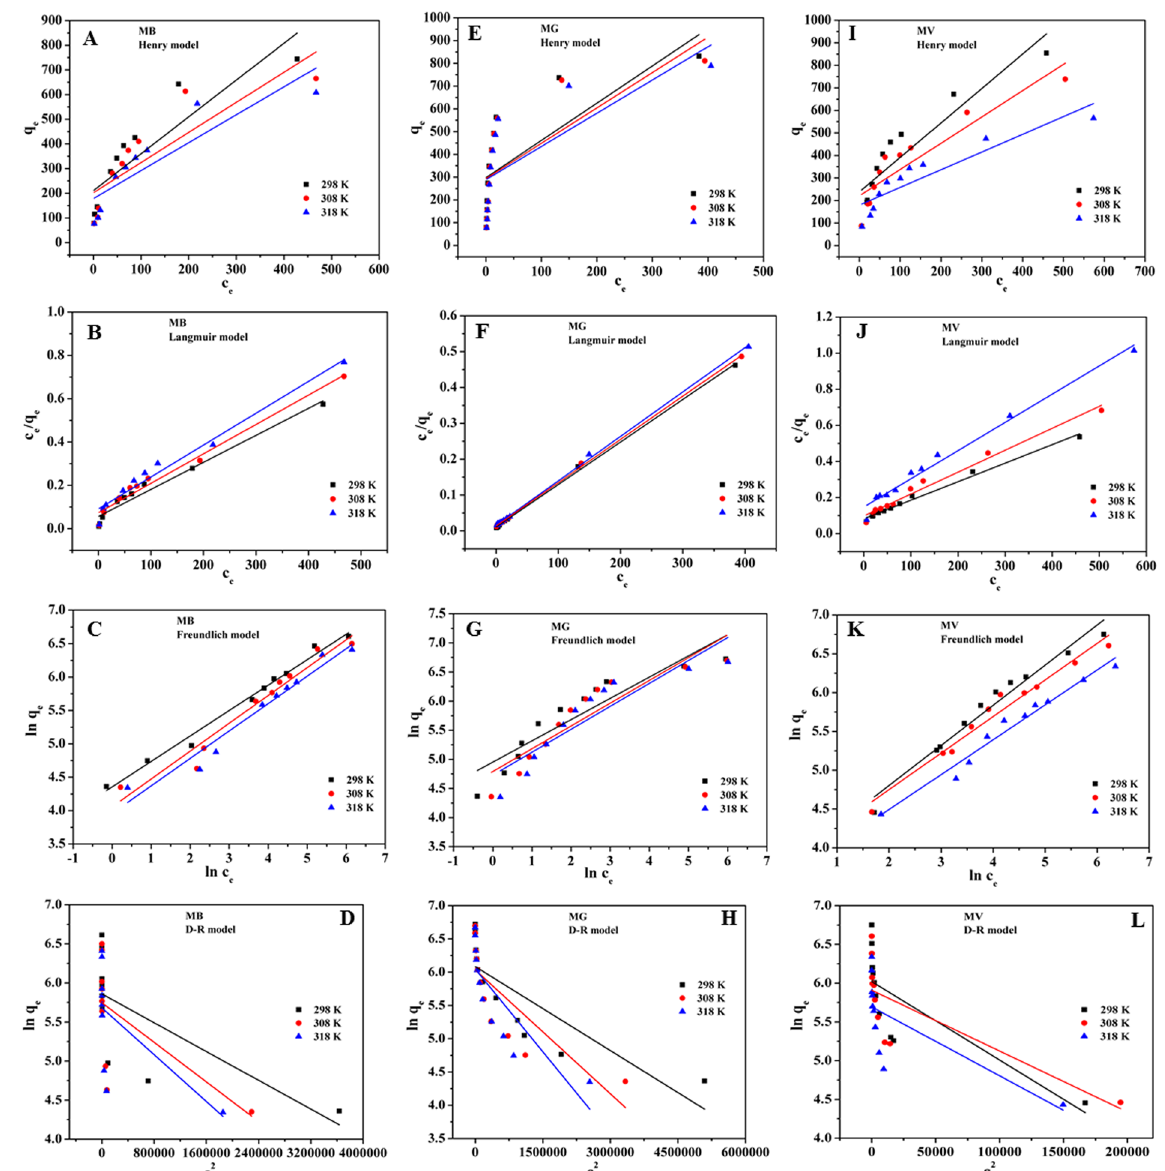
Figure 5. Henry ( A ), Langmuir ( B ), Freundlich ( C ) and D-R ( D ) adsorption isotherm fit of MB ( m = 5 mg, C 0 = 40–800 mg L − 1 , V = 10 mL, pH = 6, contact time was 10 min, temperature was 298 K, 308 K and 318 K, respectively); Henry ( E ), Langmuir ( F ), Freundlich ( G ) and D-R ( H ) adsorption isotherm fit of MG ( m = 5 mg, C 0 = 40–800 mg L − 1 , V = 10 mL, pH = 6, contact time was 120 min, temperature was 298 K, 308 K and 318 K, respectively) and Henry ( I ), Langmuir ( J ), Freundlich ( K ) and D-R ( L ) adsorption isotherm fit of MV ( m = 4 mg, C 0 = 40–800 mg L − 1 , V = 10 mL, pH = 6, contact time was 120 min, temperature was 298 K, 308 K and 318 K,